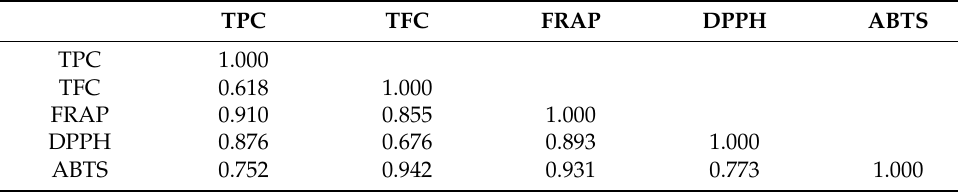
Table 3. Correlation matrix for total phenolic and flavonoid content, and antioxidant capacity.